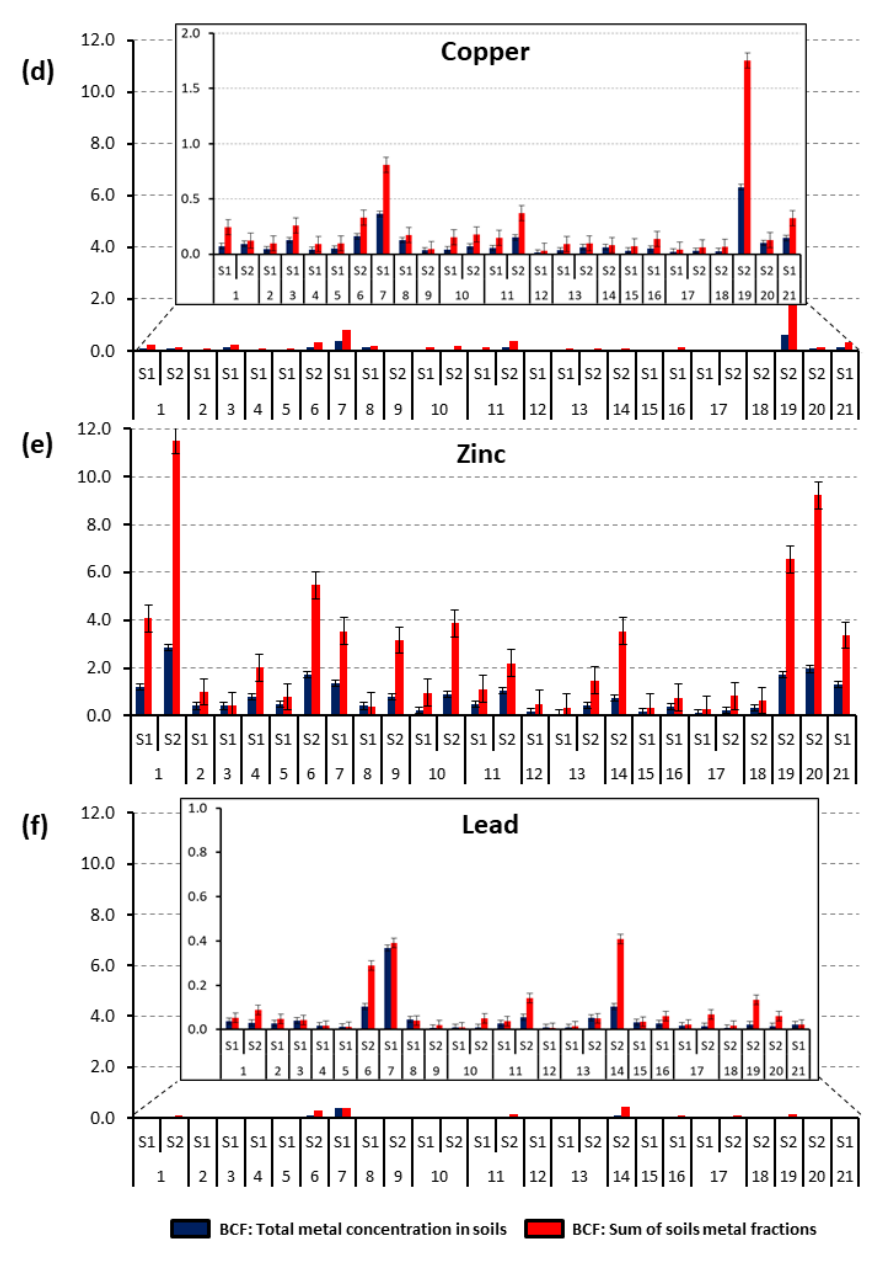
Figure 5. Bioconcentration factor (BCF) values of native species collected from two study areas (S1 and S2) in the Hualgayoc district. ( a – f ): 1— Achyrocline alata , 2— Ageratina fastigiate , 3— Ageratina glechonophylla , 4— Baccharis alnifolia , 5— Puya sp , 6— Calceolaria tetragona , 7— Arenaria digyna , 8— Bejaria sp , 9— Gaultheria glomerata , 10— Pernettya prostrata , 11— Hypericum